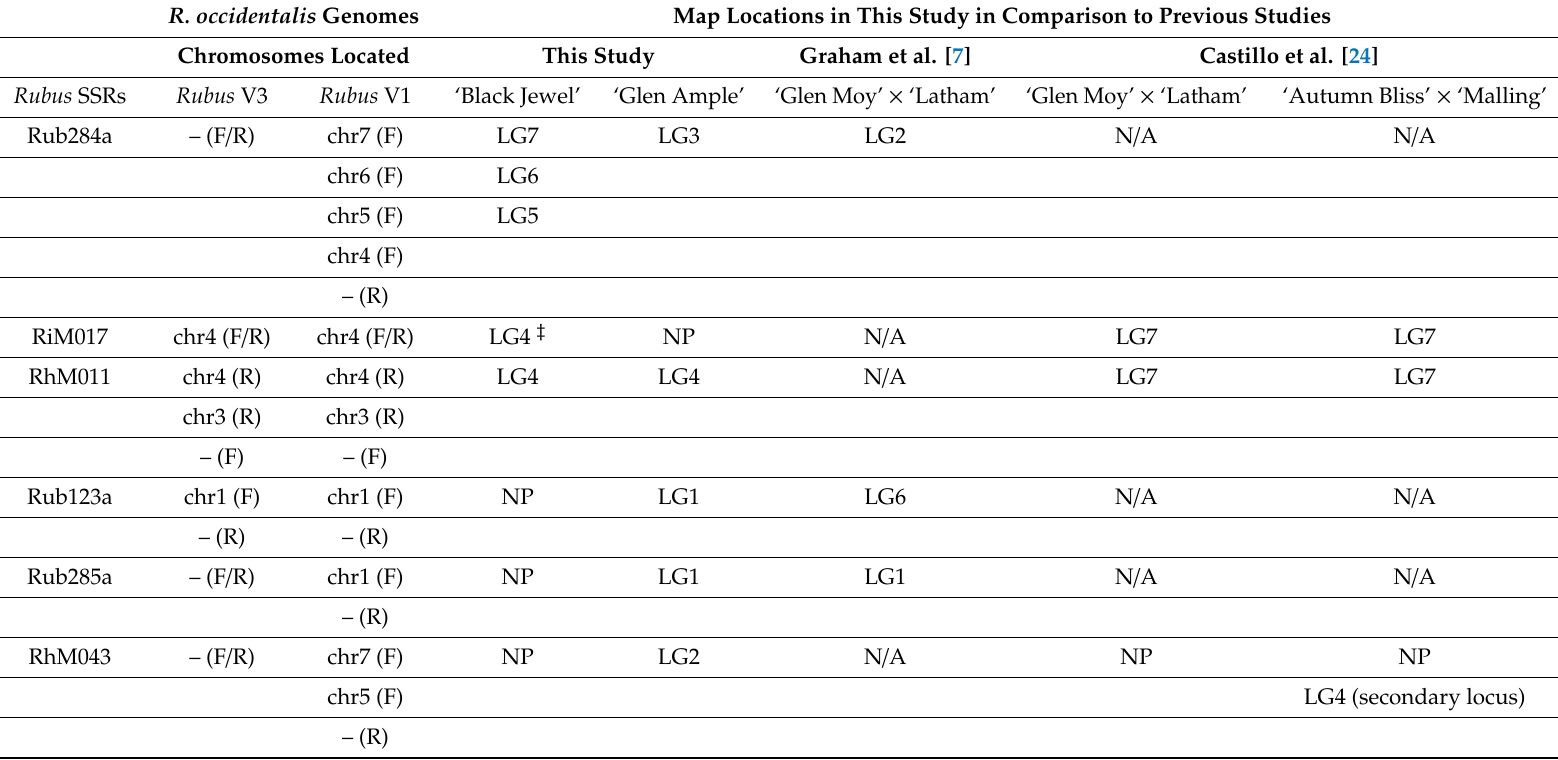
Table 3. Map positions of Rubus SSR markers in comparison to the Rubus genomes and other mapping studies. R. occidentalis